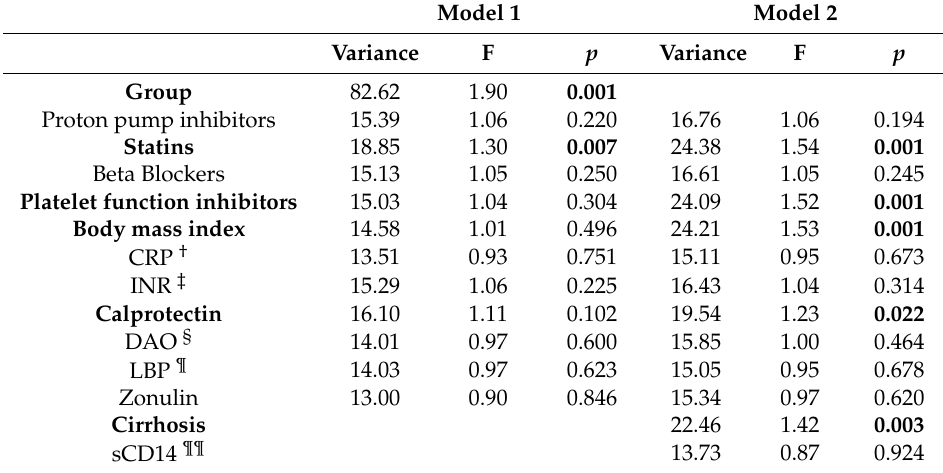
Figure 3. RDA plots for statin intake and cirrhosis. Each point on the diagram presents one study proband. ( A ) People not taking statins are shown in green, people taking statins are shown in orange ( p = 0.004). ( B ) Patients with cirrhosis are drawn green, controls not suffering from cirrhosis in yellow ( p = 0.004). In both graphs, clustering of belonging groups can be observed, indicating that cirrhosis and statin intake are possible explanatory variables for microbiome composition. The table shows results of the two used multivariate models (RDA + ) to outline microbiome-influencing factors. Group assignment, statin intake, platelet function inhibitor intake, BMI, calprotectin and cirrhosis remained possible explanatory variables for microbiome perturbations, with only statin intake being significant in both models. Significant confounders are marked in bold. In column one of each model, the variance is shown, in column two, results of the F-test are shown and in column 3, the p -value is